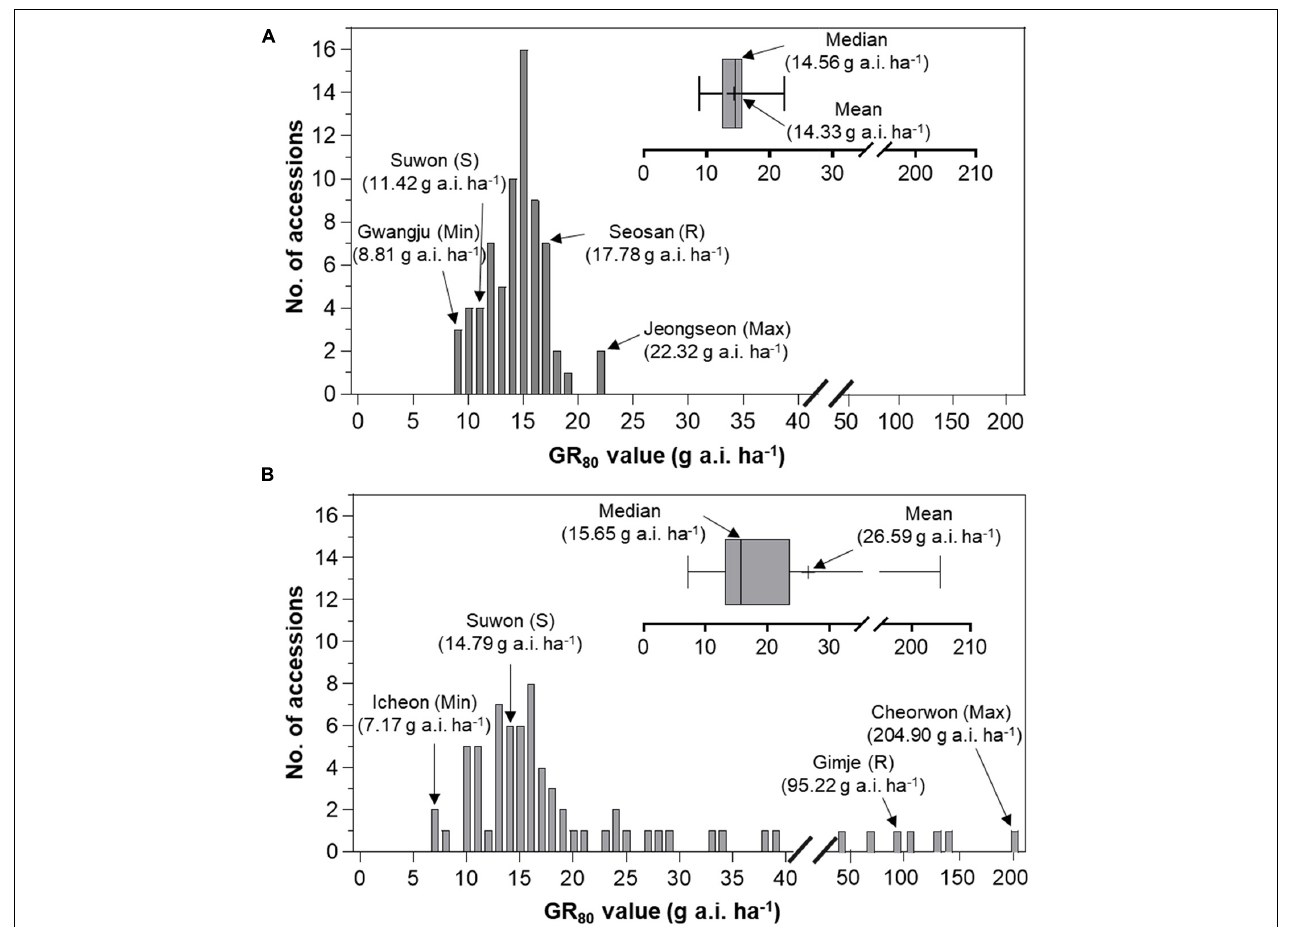
FIGURE 6 | Distribution of GR 80 values of florpyrauxifen-benzyl to (A) Echinochloa crus-galli and (B) Echinochloa oryzicola accessions.